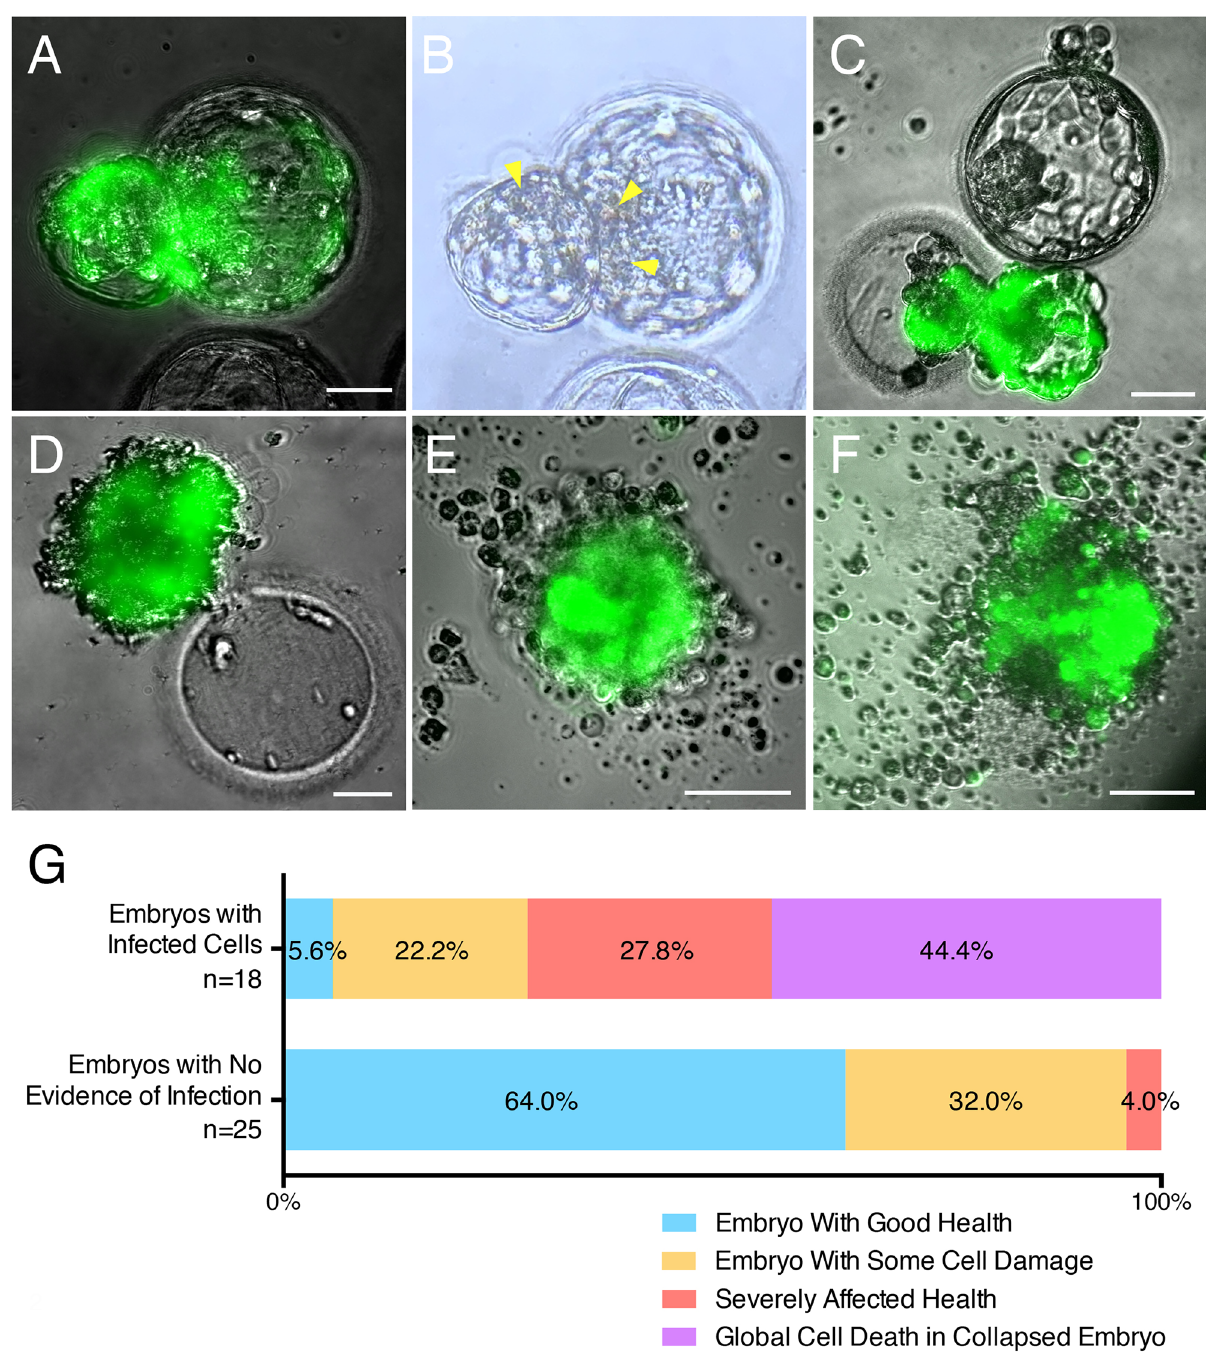
Figure 6. Embryo Health is Negatively Affected by SARS-CoV-2 Infection. Sample images of infected embryos with various degrees of cytopathic effects. ( A,B ) Embryo with cell damage (yellow arrowheads) in fluorescent (infected) cells in the herniating and zona pellucida compartments. ( C ) Infected herniating embryo (bottom) with severely affected health, and non-infected embryo (top) with good health. ( D ) Hatched infected embryo next to empty zona pellucida, displaying global cell death. ( E,F ) Examples of infected embryos displaying total collapse and death. ( G ) Summary of embryo health 12–16 h after exposure to SARS-CoV-2. Top bar includes all embryos with evidence of infection (fluorescent cells). Bottom bar includes all embryos with no evidence of infection (no fluorescent cells). Scale bars represent 50